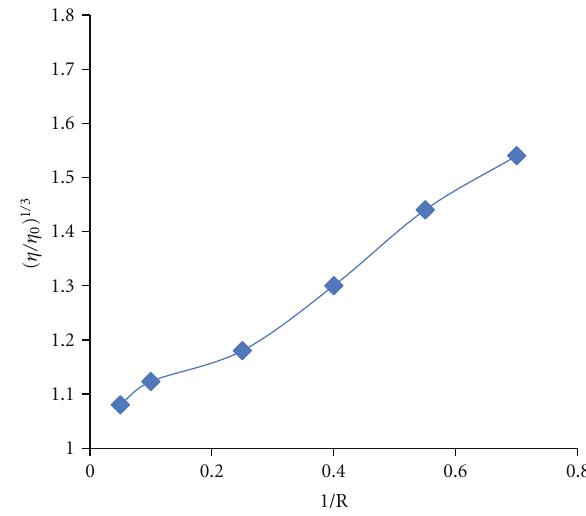
Figure 5: E ff ect of increasing amounts of complex on the viscosity of CT-DNA (5 × 10 − 5 M) in Tris-HCl